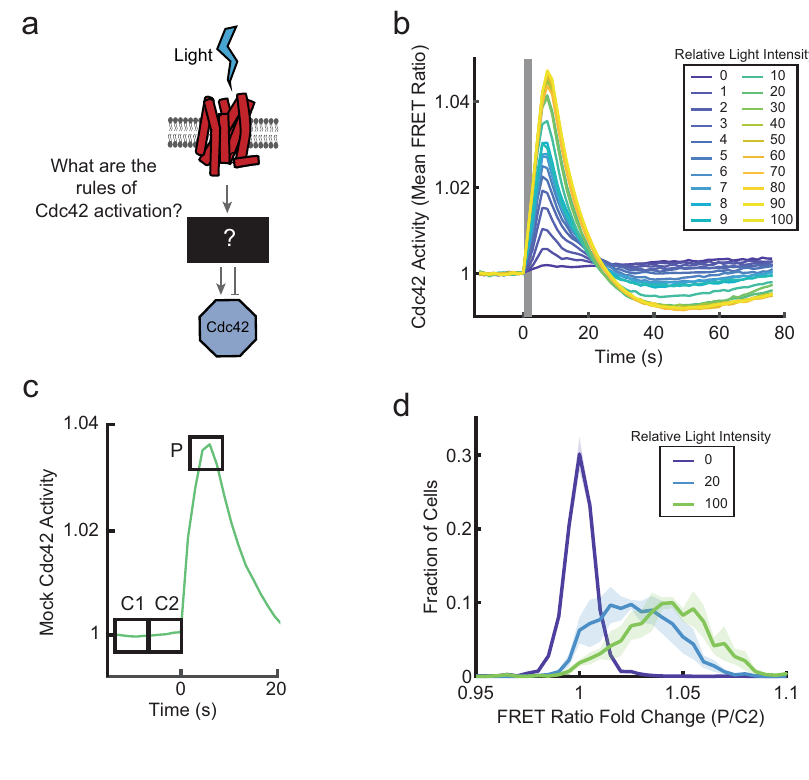
Fig. 2 Dose-dependent positive and negative signals downstream of receptors shape a graded Cdc42 response. a Schematic of unknown signal processing between receptors and Cdc42. b Populations of differentiated PLB-985 cells expressing parapinopsina and the Cdc42-TomKat sensor were stimulated with a single light pulse of the indicated intensities. The mean FRET ratio was measured as a function of time. Stimulus duration is indicated by the gray bar. A minimum of seven-well replicates was performed for each condition (exact numbers listed in the “ Methods ” ). See Supplementary Fig. 1a for the plot with error bars. Tens to hundreds of cells were imaged in each well. c Schematic for analysis of single-cell response amplitudes. For each cell, the response was broken into three, 6 s windows. The mean FRET ratio was calculated for each window (C1 = − 13.5 to − 7.5 s, C2 = − 6 to 0 s, P = 4.5 to 10.5 s). d Histograms of single-cell response amplitudes to a single light-pulse stimulus of the indicated intensities. FRET ratio fold change was calculated by taking the ratio of the peak response (P) to the control window (C2). Total cell numbers of n = 4127 cells (relative light intensity = 0), n = 2317 cells (relative light intensity = 20), and n = 2261 cells (relative light intensity = 100) were analyzed from four independent experiments. Data are presented as mean ± s.e.m. ( n experiment = 4). Source data are provided as a Source Data fi